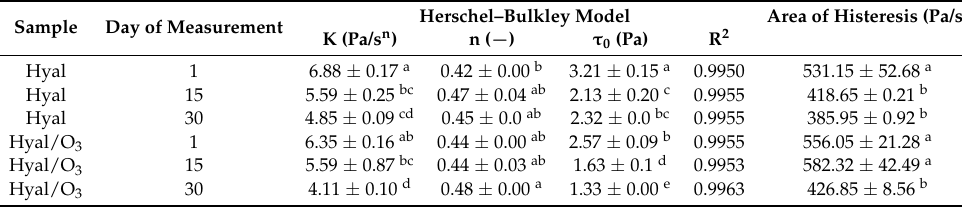
Table 2. Apparent viscosity of the gels at different shear